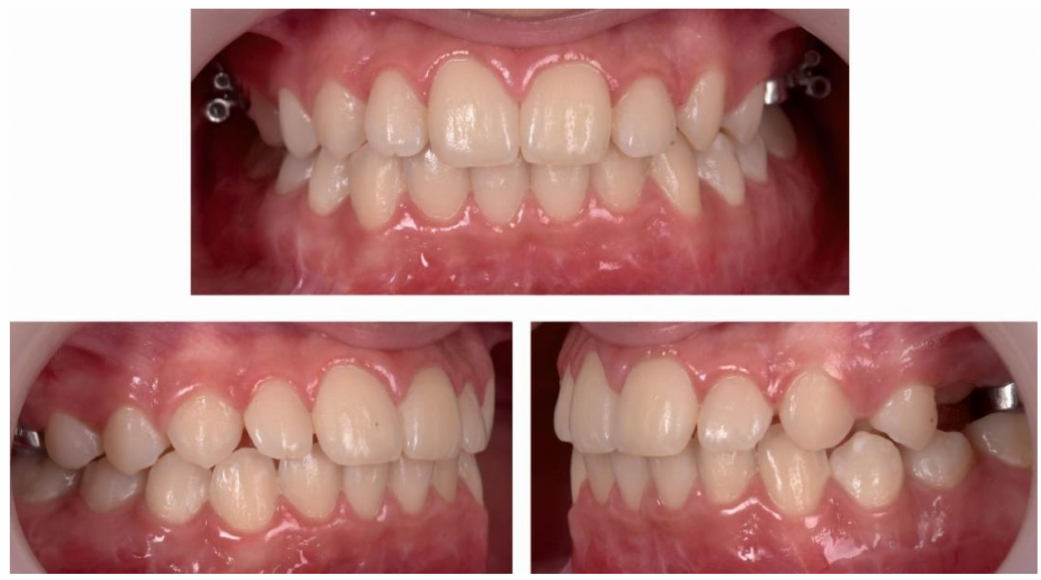
Figure 18. Intra-oral aspect after 15 months of treatment with TPA and mandibular acrylic